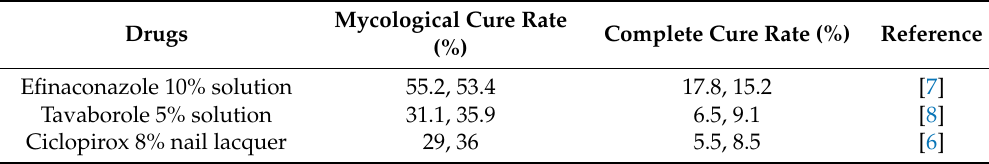
Table 2. Collective table of mycological and complete cure rates of efinaconazole 10%